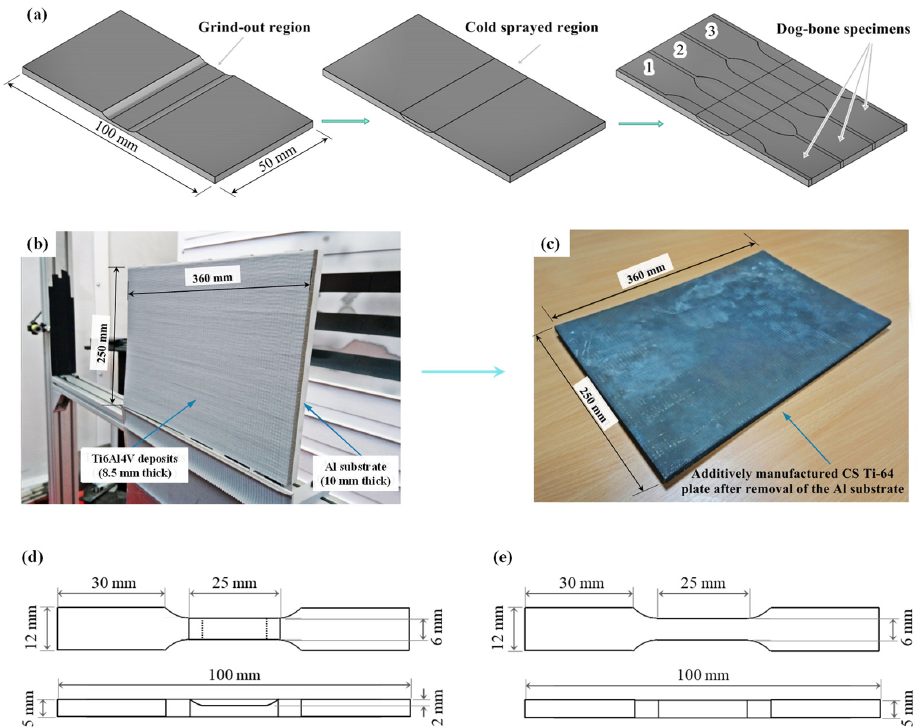
Figure 1. ( a ) Manufacturing steps of the repair tensile specimens; ( b , c ) manufacturing of the fully CS Ti6Al4V plate for extracting specimens for mechanical testing from 8.5 mm thick CS Ti6Al4V deposited on Al 5083-0 substrate, ( c ) a fully CS Ti6Al4V plate after removing the substrate; ( d , e ) dimensions of tensile specimens: ( d ) repair ratio 2:5, ( e ) fully CS.